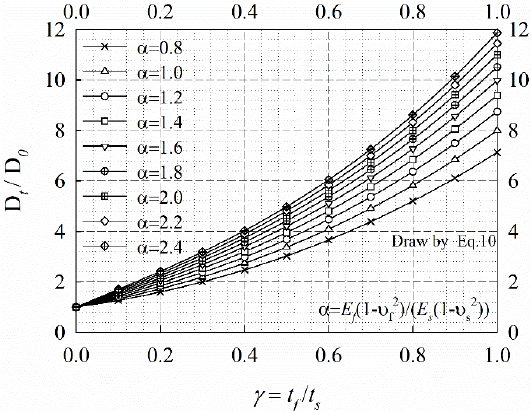
Figure 4. Variation of Stiffness enhancing ratio D t / D 0 calculated by Equation (10) as a function of γ .